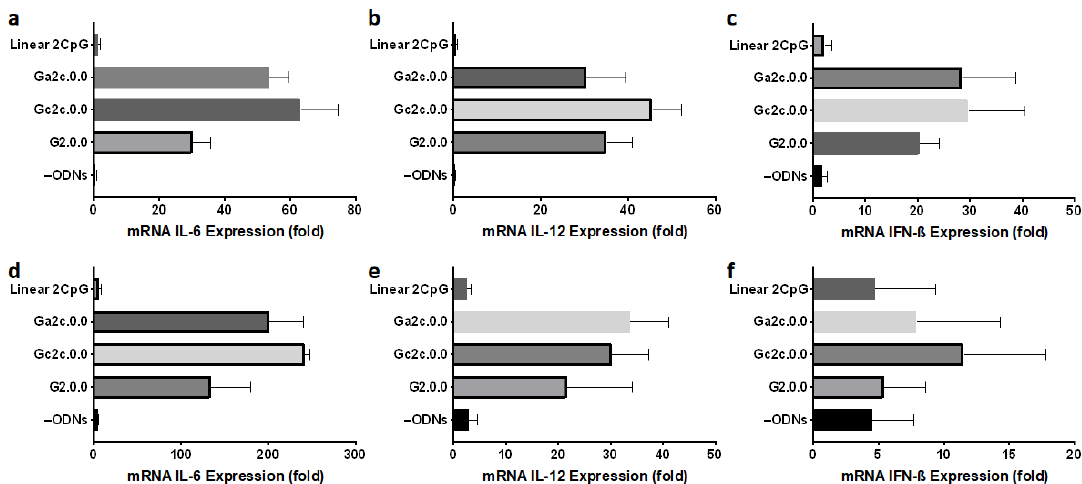
Figure 8. Immunostimulatory effect of antiparallel type CpG ODNs in ( a – c ) DC2.4 mouse dendritic cells and ( d – f ) bone marrow ‐ derived macrophage cells (BMDMs). Messenger RNA expression levels of cytokines ( a , d ) IL ‐ 6, ( b , e ) IL ‐ 12, and ( c , f ) IFN ‐ ß were determined using RT/RQ ‐ PCR. The cells (DC2.4; 1 × 10 5 cells/well, BMDMs; 0.56 × 10 5 cells/well) were stimulated by 2 μ M G2.0.0, Gc2c.0.0, and Ga2c.0.0 and linear 2CpG for 24 h. –ODNs indicate RAW264 cells with only D ‐ PBS buffer added. Data are presented as mean ± SD ( n = 5).